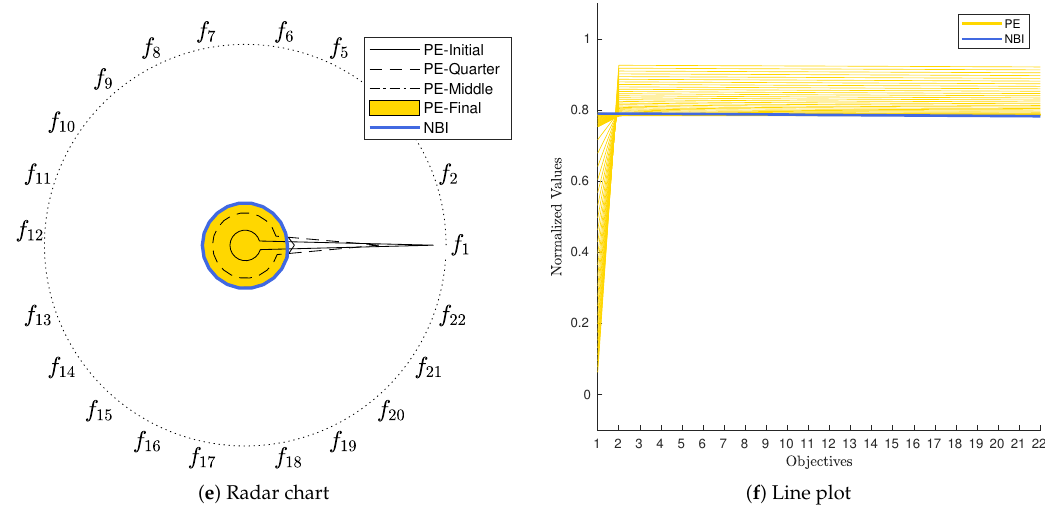
Figure 9. Numerical results for the minDTLZ2 problem for k =